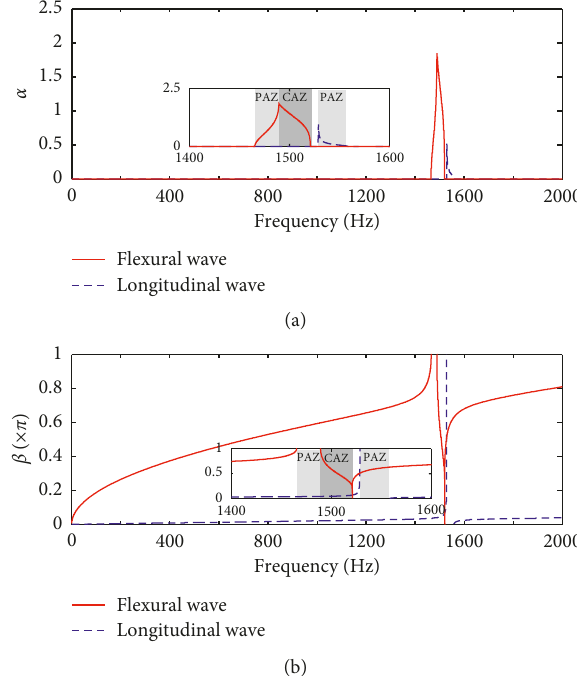
Figure 4: Propagation constant of the composite